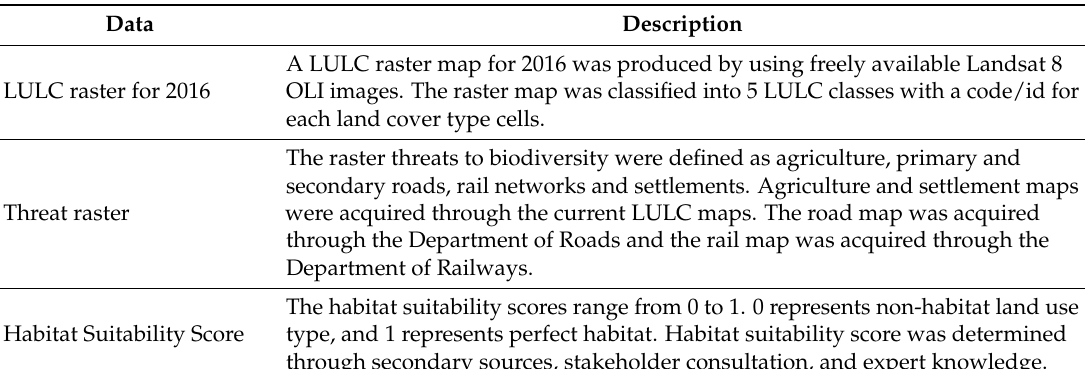
Table A2. Summary of the input data types and description for InVEST HQ